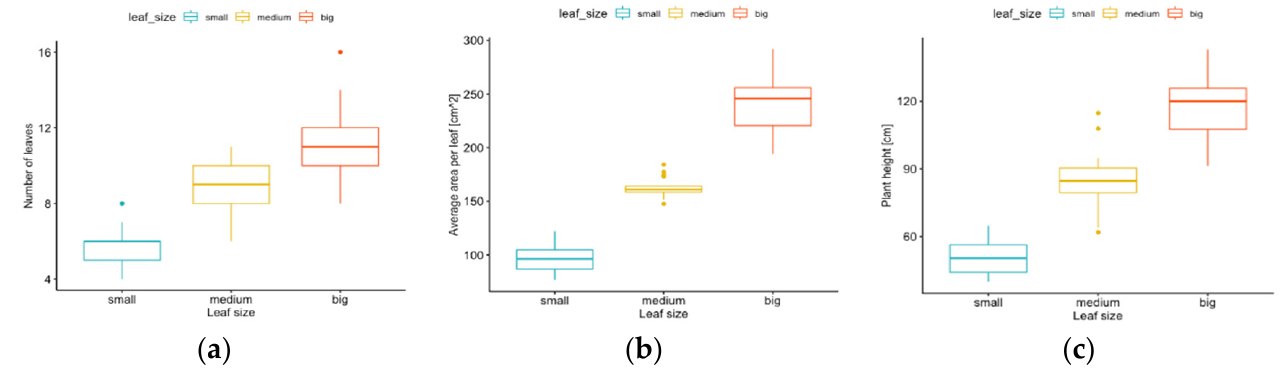
Figure 4. The general description of three plant groups with different leaf sizes (small, medium, big) ( a ) number of leaves; ( b ) individual leaf area averaged per plant (cm 2 ); ( c ) plant height (cm) for three groups. The leaf area (cm 2 ) is estimated by leaf length (cm) × leaf width (cm) × 0.743